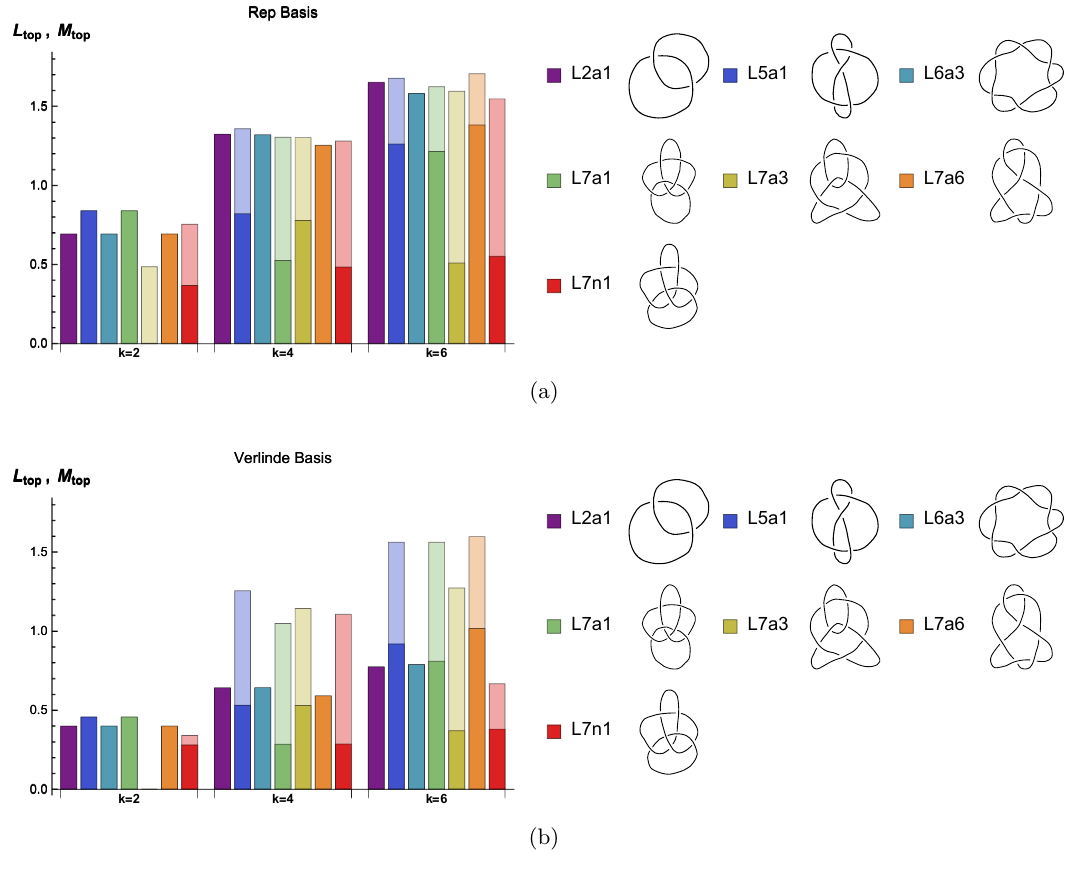
Figure 4 . The topological long-range mana, L top , is charted for seven different two-links. Behind each bar, that link state’s full topological mana, M , is plotted at half-opacity. This done for top k = 2 , 4 , and 6 (i.e. dim H = 3 , 5 , and 7 , respectively) in both the rep basis (subfigure (a)) and the Verlinde basis (subfigure (b)). Note that only for the two torus links, L2a1 and L6a3, are L top and M top always